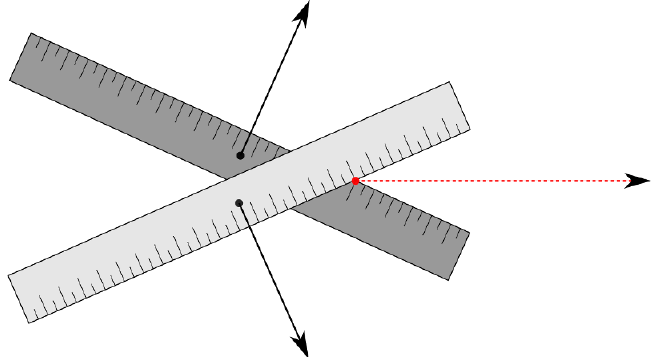
Figure 3 . Two rulers moving at an angle. The red dot to the right indicates the point of intersection of the rulers. As the rulers move away in diverging directions, their point of intersection may move at superluminal speed, but without transport of